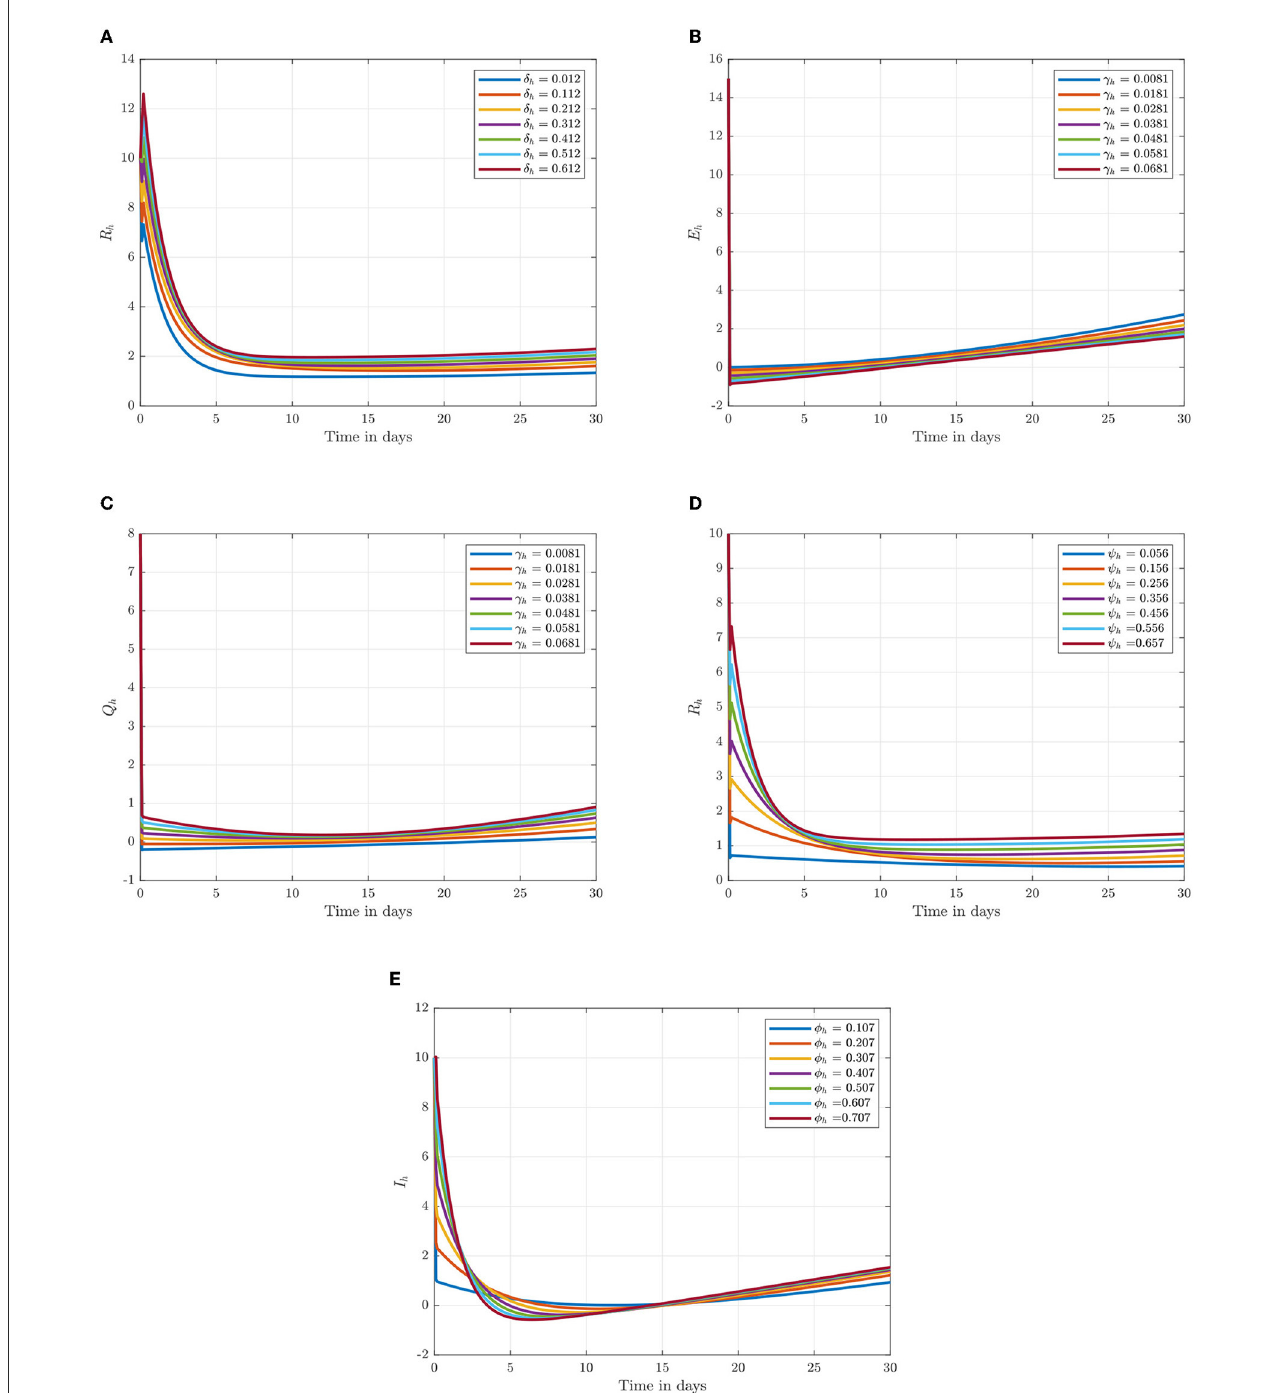
FIGURE6 Numerical trajectory of varying δ h , γ h , ψ h , and φ h when α γ h on quarantine class. (D) Variation of ψ h on recovery class. (E) Variation of φ h on infected class.